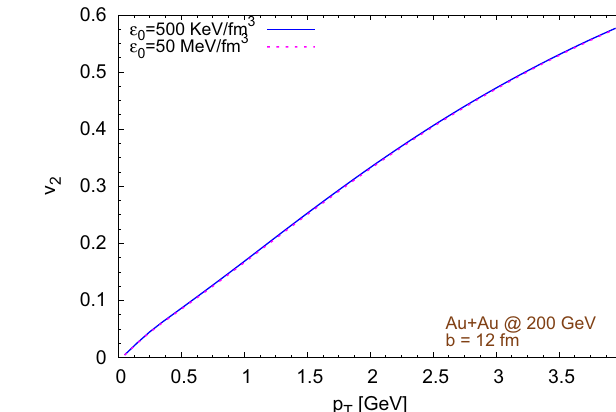
Fig. 15 Ratio between the initial magnetic pressure and thermal pres- sure B 2 /( 2 p ) . Left figure: Au+Au collisions at τ = 0 . 4 , fm/c. Right figure: Pb+Pb collisions at 0 τ = 0 . 2 , fm/c. Both figures refer to collisions with an impact parame- 0